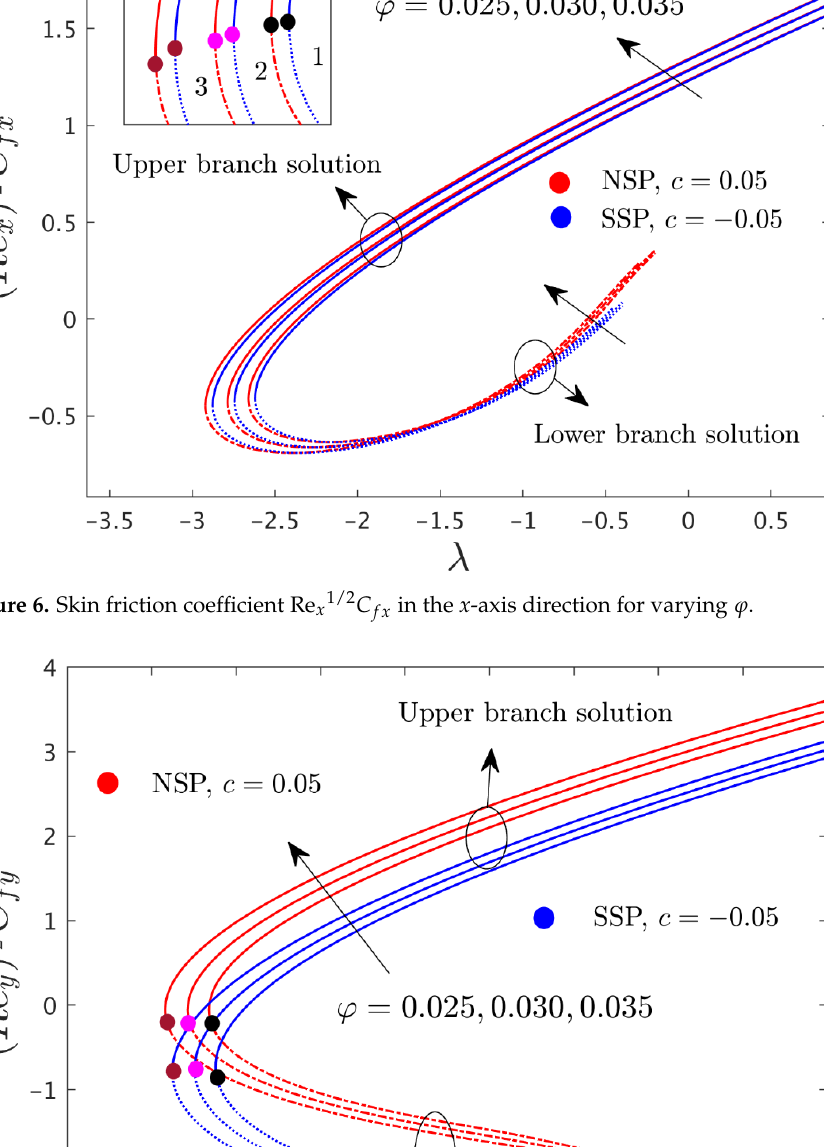
Figure 7. Skin friction coefficient Re y 1/2 C fy in the coordinates of the y -axis for varying ϕ .